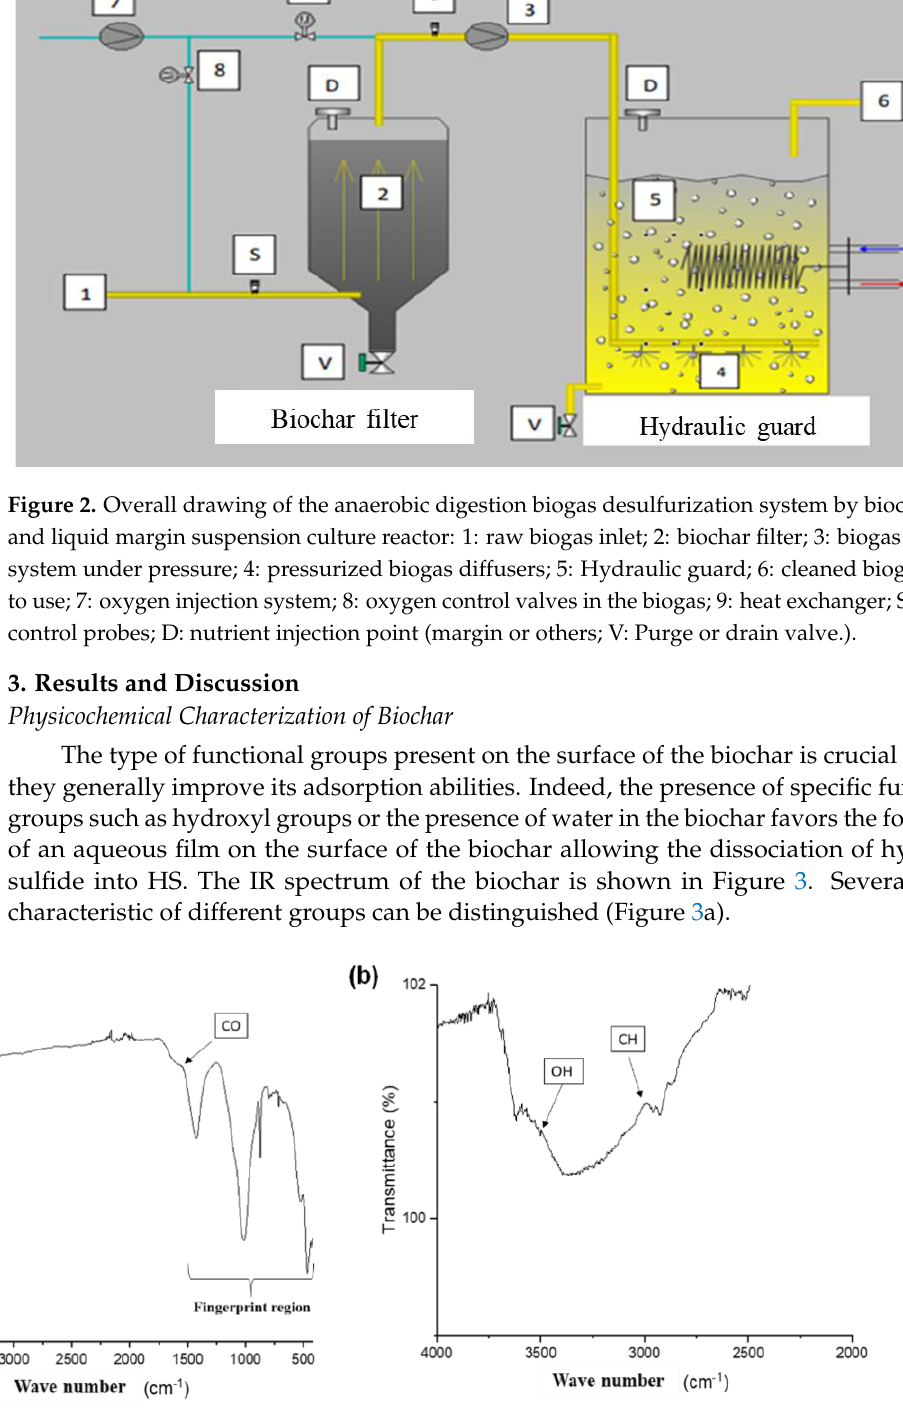
Figure 3. ( a ) The infrared spectrum of biochar synthesized by pyrolysis of the sludge – margin mixture, ( b ) infrared spectrum of biochar synthesized in the region of wave numbers between 4000 and 2000 cm − 1 .